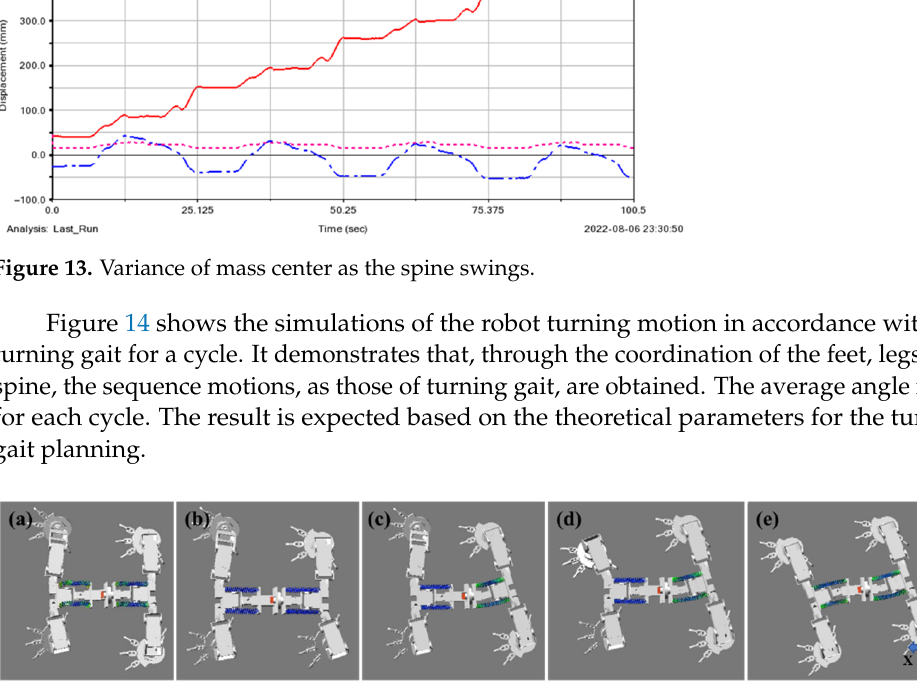
Figure 14. Turning gait; ( a – e ) five movements in one locomotion cycle.